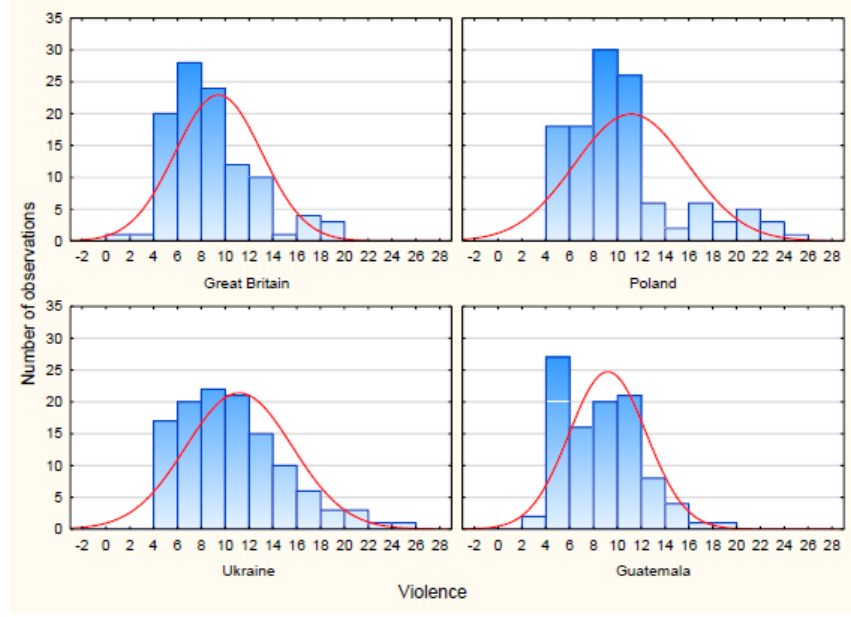
Note: Sample n = 441 Figure 6. Distribution of responses for